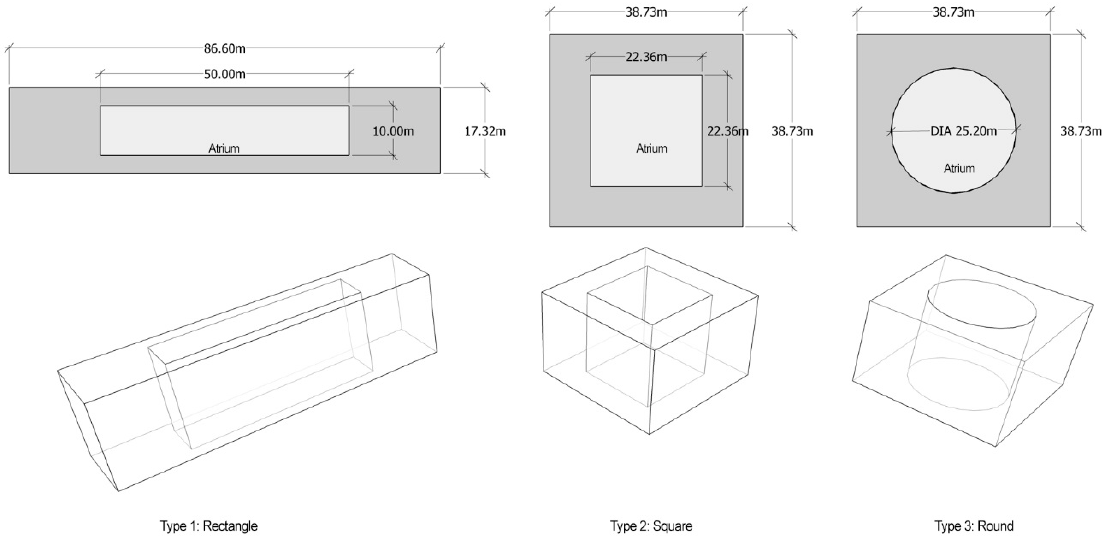
Figure 1. Plan and 3D views of the three atrium types.